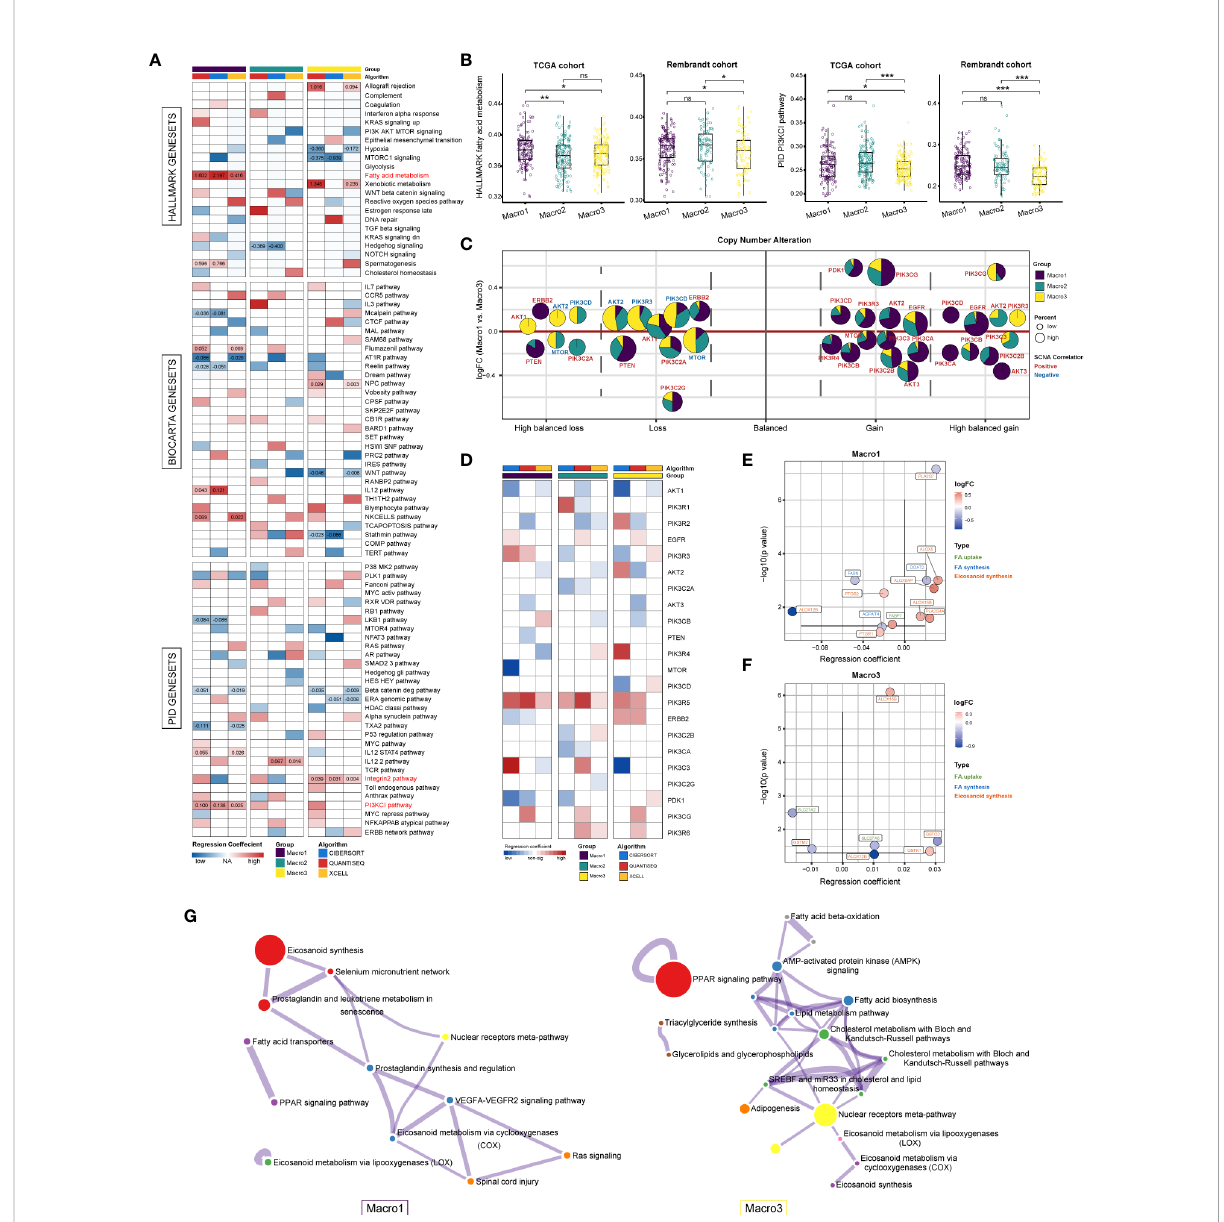
FIGURE 2 Resolving signaling pathways correlated with M2 fraction using multivariate regression analysis. (A) Correlation between M2 fractions and the 538 HALLMARK, BIOCARTA, and PID signaling pathways. Regression coef fi cients that were signi fi cant in at least two independent algorithms were marked. (B) Comparison of the ssGSEA score of the PID PI3KCI pathway and HALLMARK FA metabolism between groups. (C) Evaluation of the correlation between genes with signi fi cant copy number variants in the PI3K pathway and M2 fraction based on logistic regression. The colors represent the regression coef fi cients between a certain type of SCNA of a gene and the M2 fraction, with red being positive and blue being negative. The size of the bubble represents the frequency of SCNA. The area of the sector indicates the distribution of this type of SCNA of a gene in each group. (D) Assessing the correlation between the mRNA expression of PI3K pathway members and M2 fraction using multivariate linear regression. We determined results with signi fi cant and consistently positive and negative regression coef fi cients in two or more algorithms were statistically signi fi cant. (E, F) The correlation between FA metabolism genes and M2 fraction in Macro1 and Macro3. Colors represent the log2FC (Macro1 vs. Macro3). (G) Functional enrichment analysis of FA metabolic genes that are signi fi cantly associated with the M2 fraction in each group. *p < 0.05, **p < 0.01, ***p < 0.001. ns, non signi fi